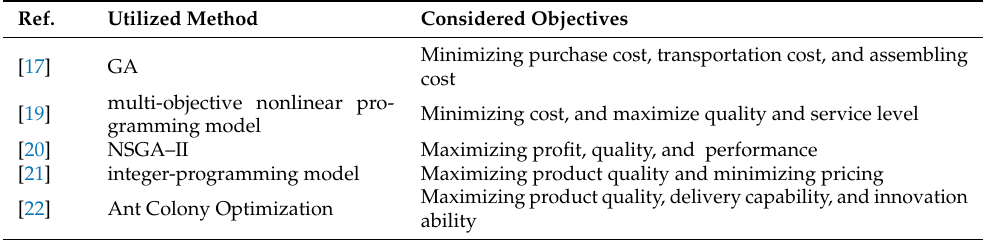
Table 1. A summary of the related work.